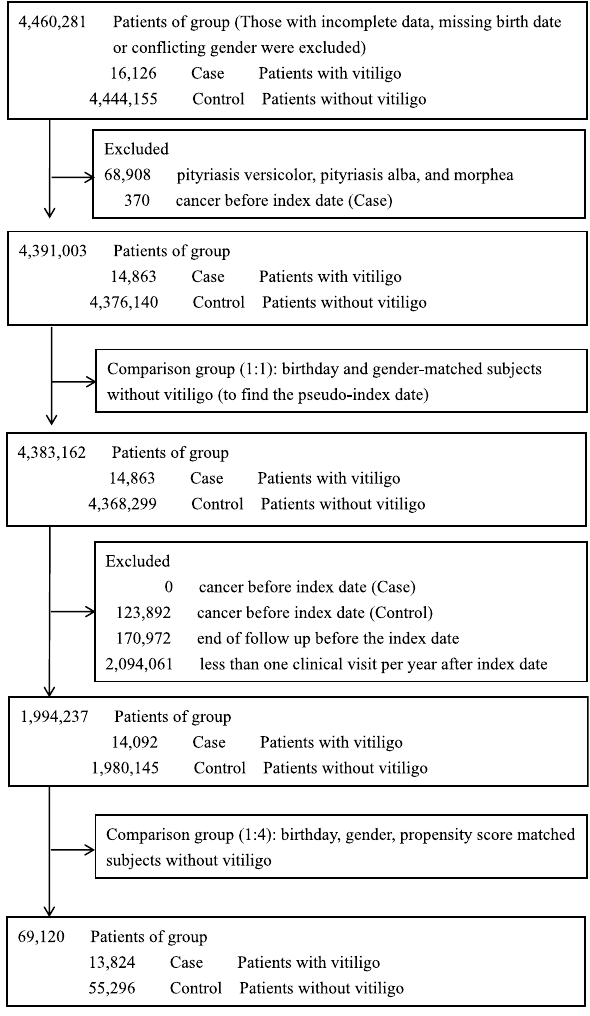
Figure 1. Selection process for subjects in vitiligo and control